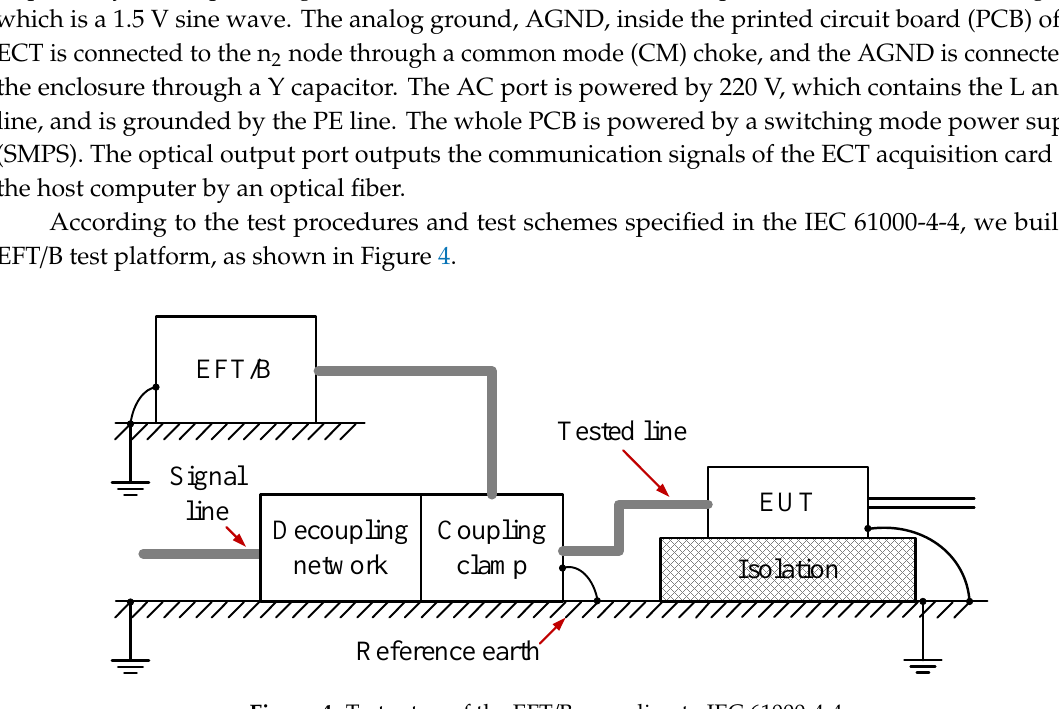
Figure 4. Test setup of the EFT/B according to IEC 61000-4-4.